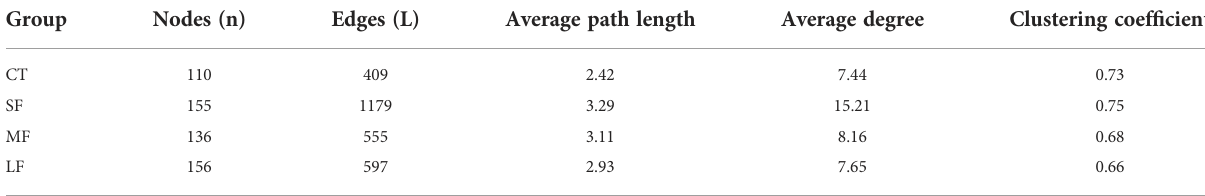
TABLE 3 Topological characteristics of the gut microbial network of juvenile crabs at different levels of DTF (28°C, 28 ± 2°C, 28 ± 4°C, 28 ± 6°C). Group Nodes (n) Edges (L) Average path length Average degree Clustering coef fi